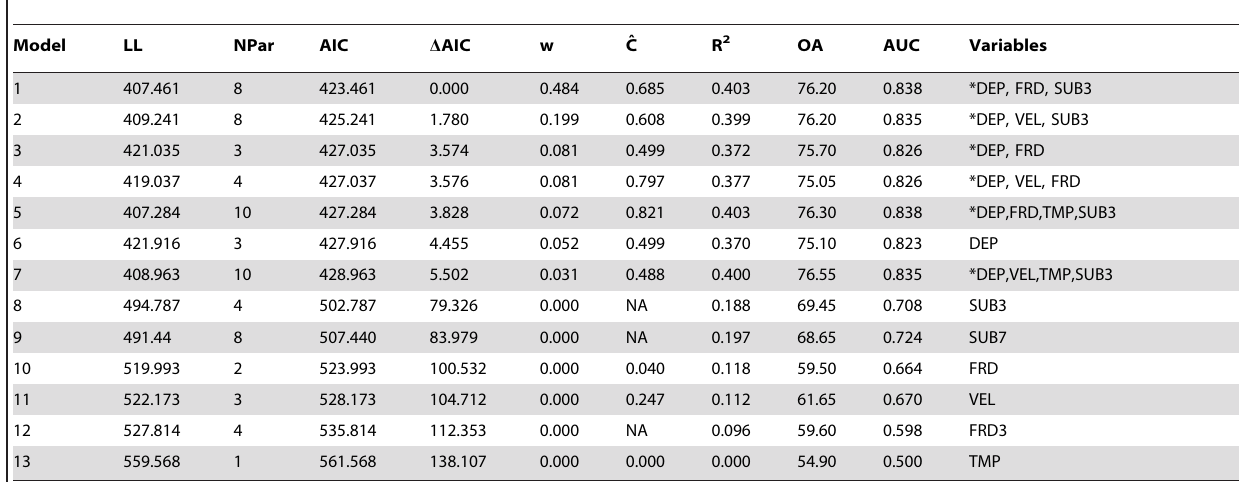
Table 2. Model results for univariate and multivariate logistic regression, listed from best to worst according to AIC score ( n = 450; 309 absences and 141 presences).